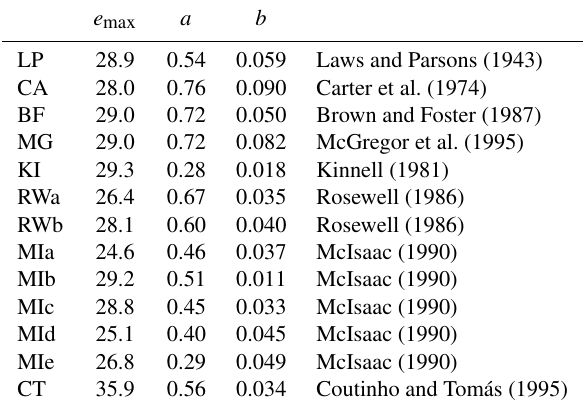
Table A1. Coefficients for calculation of rainfall kinetic energy in Eq. (A2). The acronyms used throughout the paper are given in the first